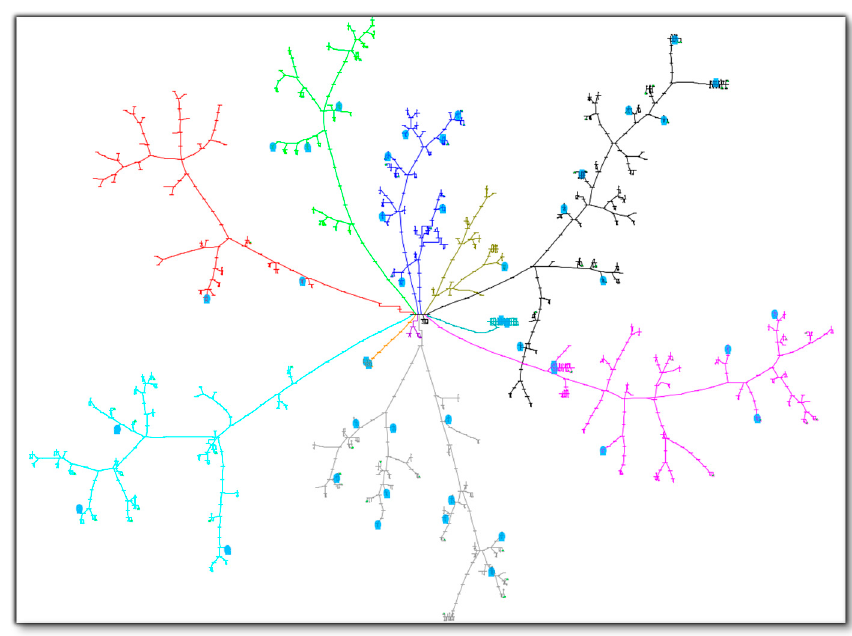
Figure A4. Use case 1—Location of PVs.